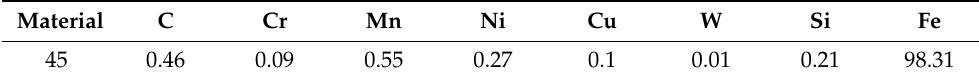
Table 1. Chemical composition of steel 45